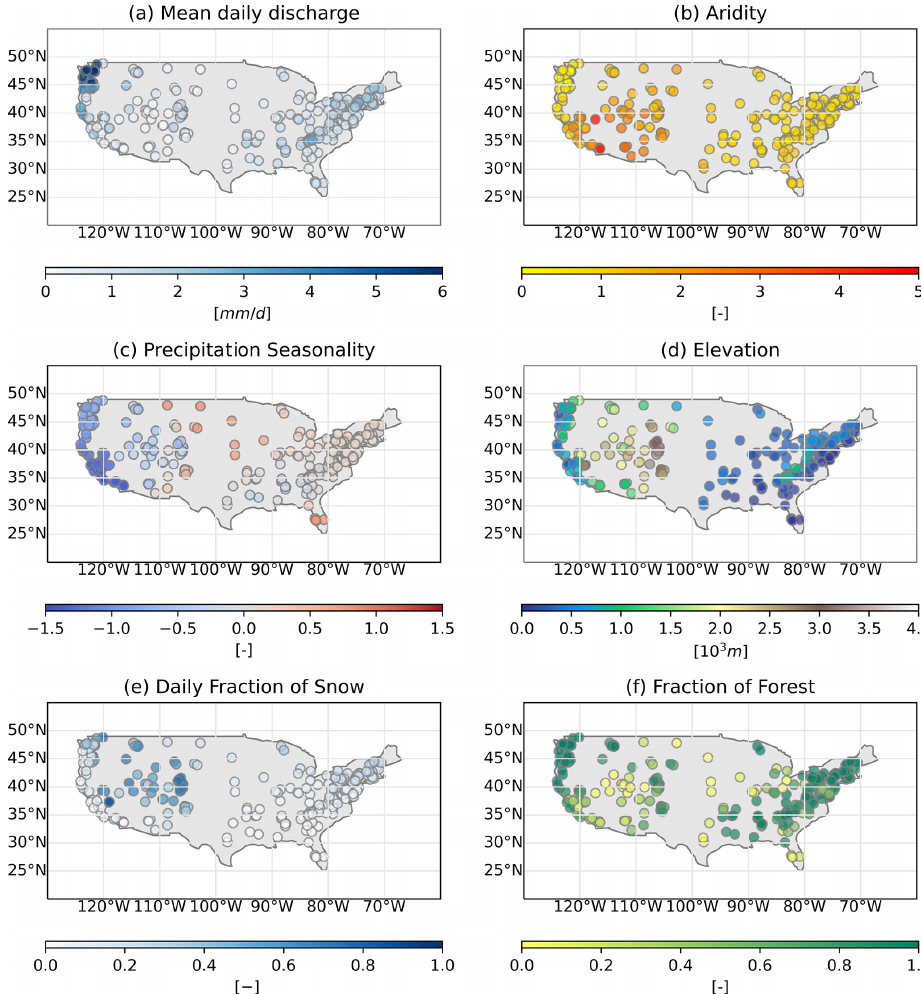
Figure 1. Catchment attributes extracted from the CAMELS database: (a) mean daily discharge (mmd − 1 ); (b) aridity as PET/P; (c) precip- itation seasonality, where positive (negative) indicates precipitation peaks in summer (winter); (d) elevation (ma.s.l.); (e) daily fraction of snow indicates the fraction of precipitation falling as snow in the case of temperatures below zero; and (f) fraction of forest.